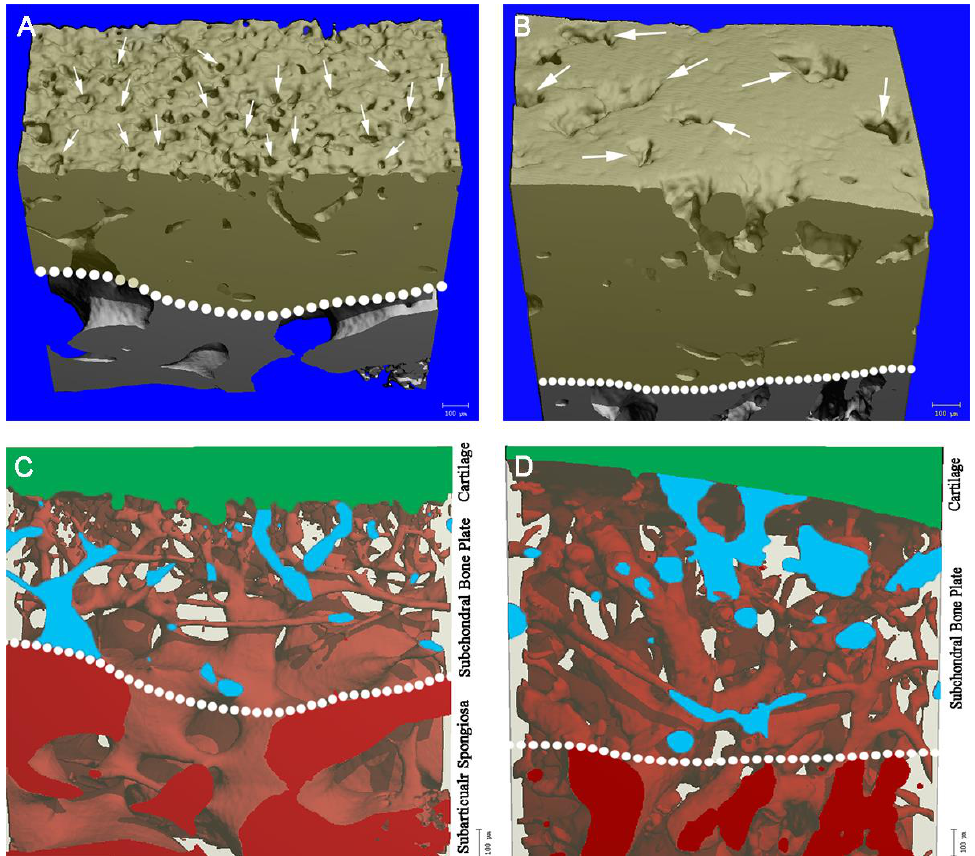
Figure 2. 3D-reconstructed images of the subchondral zone in calves ( A ) and cattle ( B ) reveals that the microchannels reach to the most superficial border of the sub-articular junction. Corresponding “negative” images of the exact cross-sections of calves ( C ) and cattle ( D ) were generated by inverting the upper and lower threshold values. Thus, the illustrated red areas are composed of the non-osseous tissues that provide a spatial representation of cavities and the connective microstructure.